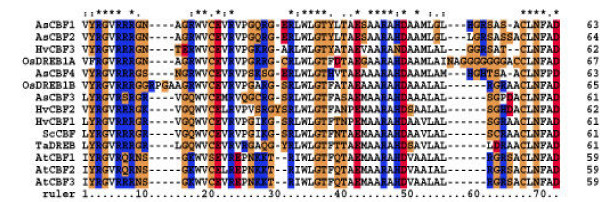
ClustalW analysis of AP2 DNA-binding domains. AP2domain of AsCBF1, AsCBF2, AsCBF3 and AsCBF4 were aligned to AP2 domains from CBF related proteins from other plants as indicated in the text to the left. Arabidopsis thaliana AtCBF1, AtCBF2, AtCBF3; Horedeum vulgare HvCBF1, HvCBF2, HvCBF3; Triticum aestivum TaDREB; Oryza sativa OsDREB1A, OsDREB1B; Secale cereale ScCBF (AC-numbers of the sequences are given in table 6). The amino acid residues are coloured based on the functionality, and the colouring schema is as follows: Acidic residues (DE) are red, basic residues (RHK) are blue, hydrophobic residues (AILMFPV) are white and hydrophilic residues (NCQGSTY) are orange.